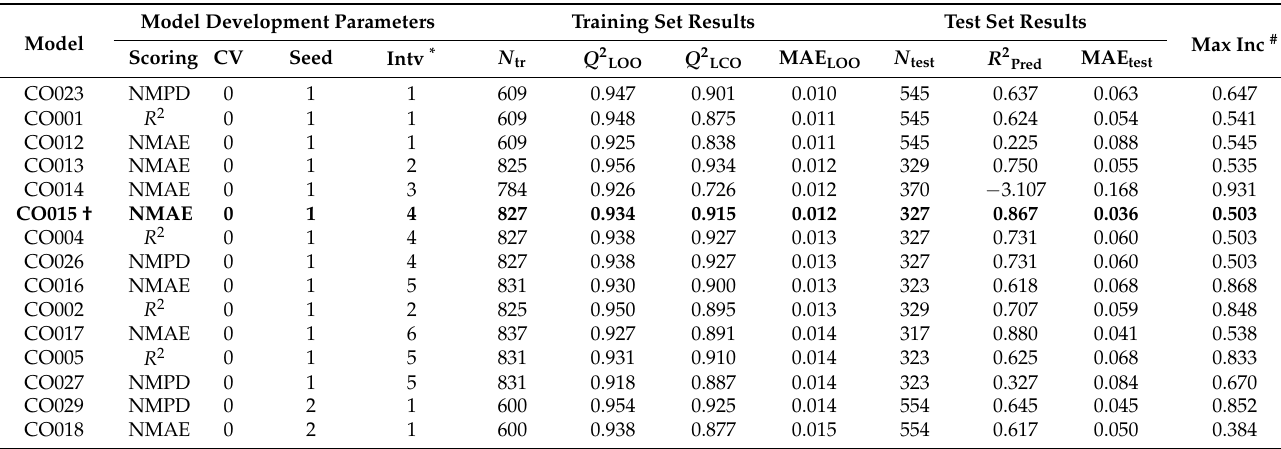
Table 2. Summary of statistical performance of the top 15 models (according to MAE LOO values) obtained from CO-based data divisions.